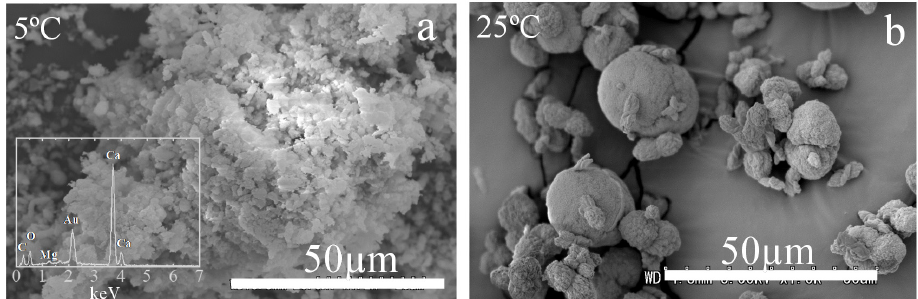
Figure 3. Scanning electron microscopy (SEM) image with energy dispersed X-ray spectroscopy (EDS) spectrum of the MHC (batch#9 in Table 1) synthesized at 5 °C ( a ) and SEM image of the MHC (batch#F1 in Table 1) at 25 °C (Fukushi et al. [13]) ( b ).